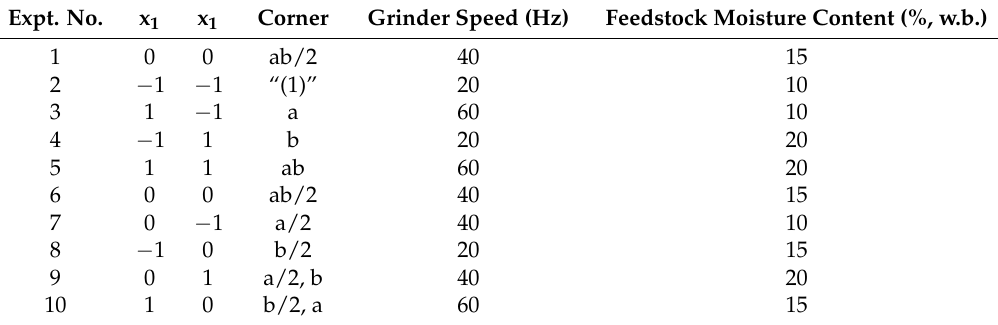
Table 2. The central composite design with coded and descriptive